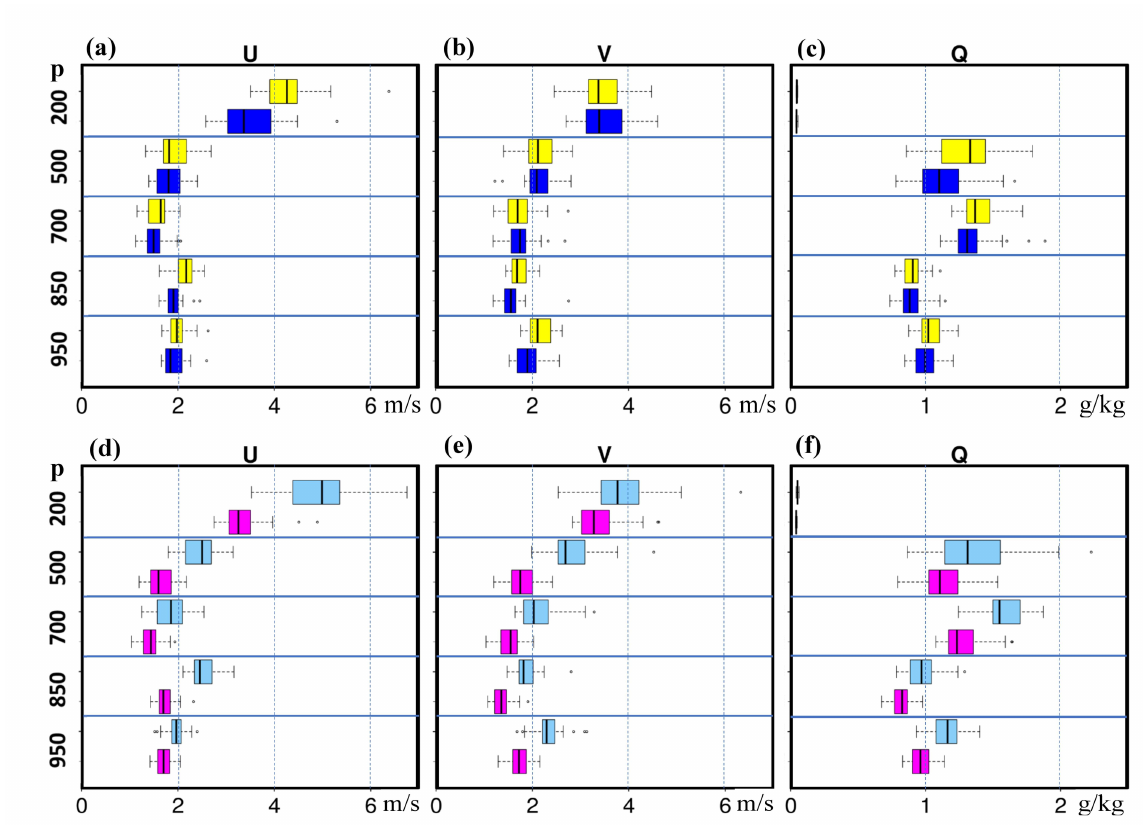
Figure 12. Same as Figure 10d–f but for ( a – c ) T9D12 (blue) and T3D12 (yellow) and ( d – f ) T5D24 (magenta) and T5D4